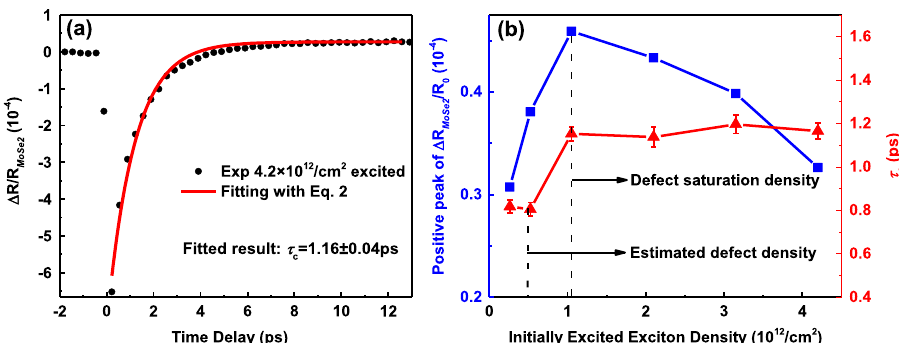
Fig. 3 a Fitting of defect capturing time using Eq. (2), with data measured at exciton density of 4.2 × 10 12 /cm 2 (60 μ J/cm 2 ). b Positive peak values and the fi tted defect capturing time as a function of free exciton